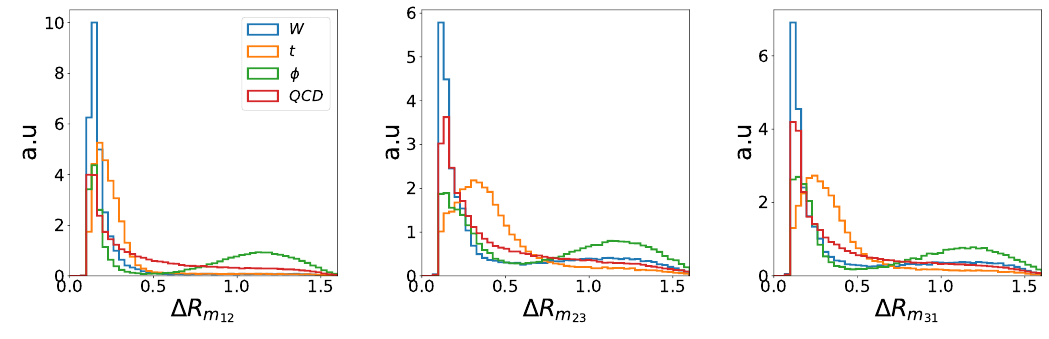
Figure 1 . Normalised angular separation distribution between three leading microjets in the fat jet for the physics scenarios discussed in this work.